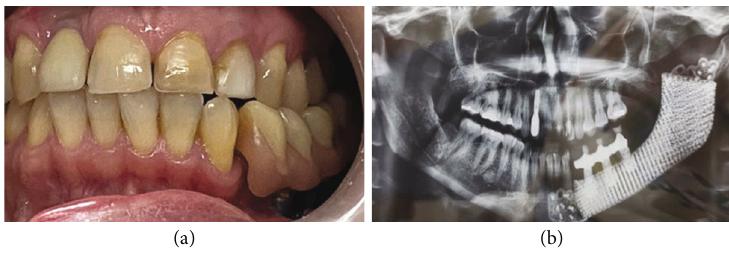
Figure 5: Intraoral view and radiograph after